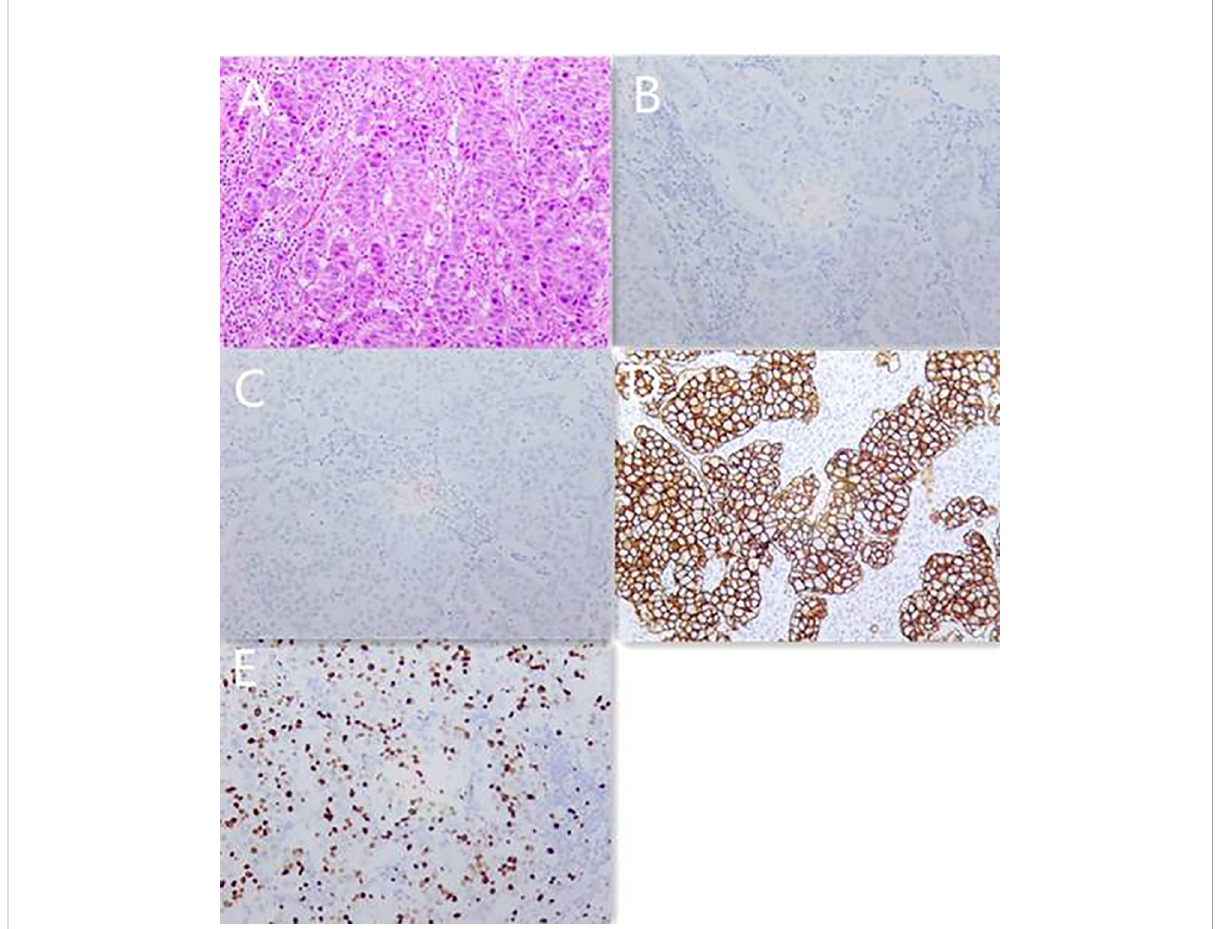
FIGURE 1 Pathology images and immunotherapy staining images of this patient in March 2020. (A) Pathology images of core needle biopsy. (B) ER immunotherapy staining image of core needle biopsy. (C) PR immunotherapy staining image of core needle biopsy. (D) HER2 immunotherapy staining image of core needle biopsy. (E) Ki-67 immunotherapy staining image of core needle